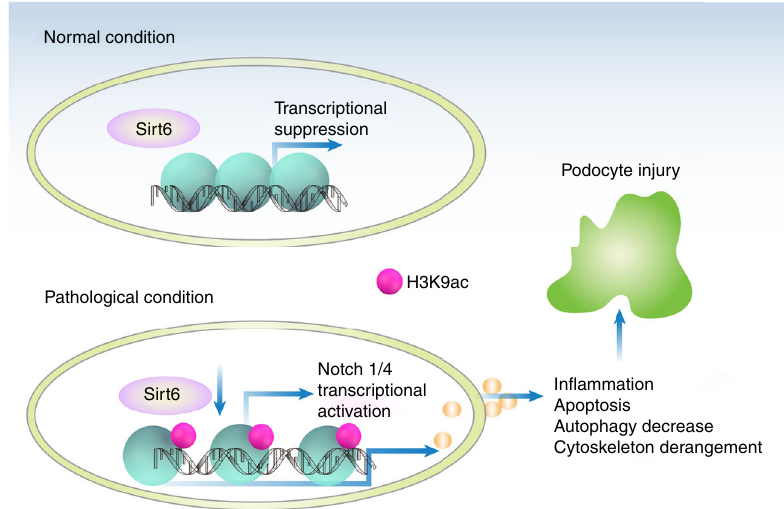
Fig. 10 Schematic depicting Sirt6 de fi ciency exacerbates podocyte injuries and proteinuria through targeting Notch signaling. Under normal conditions, SIRT6 inhibits the transcription of Notch1 and Notch4 genes by decreasing H3K9ac levels in the promoter region of Notch1 and Notch4 . Under pathological conditions, SIRT6 reduction leads to the increased levels of H3K9ac in the promoters of Notch1 and Notch4 , thereby enhancing the transcription of Notch1 and Notch4 gene. The activation of Notch signaling fi nally results in podocyte injury through inducing in fl ammation, apoptosis, actin cytoskeleton derangement, as well as the inhibition of